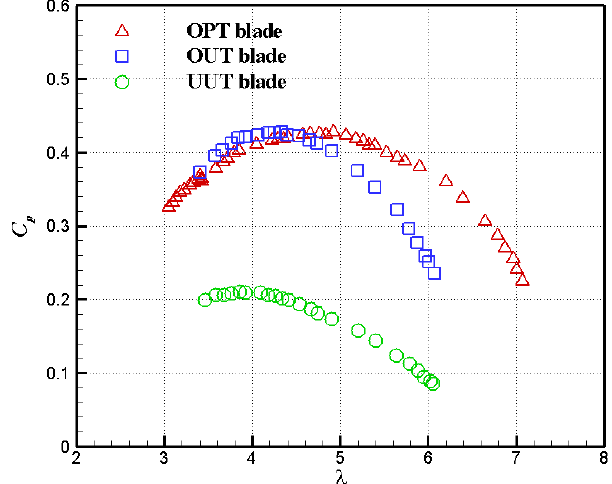
Figure 10. The experimental results of power coefficient as function of tip speed ratio for OPT, UOT and UUT blades at V = 10